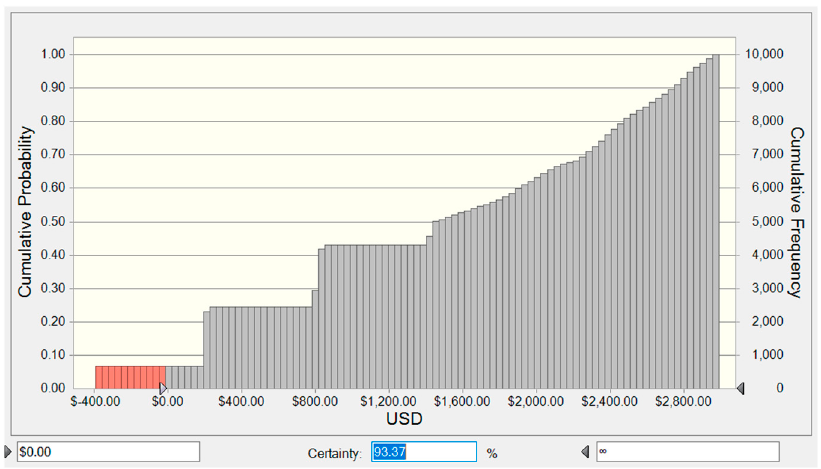
Figure 8. Stochastic results of NPV in the SO region.